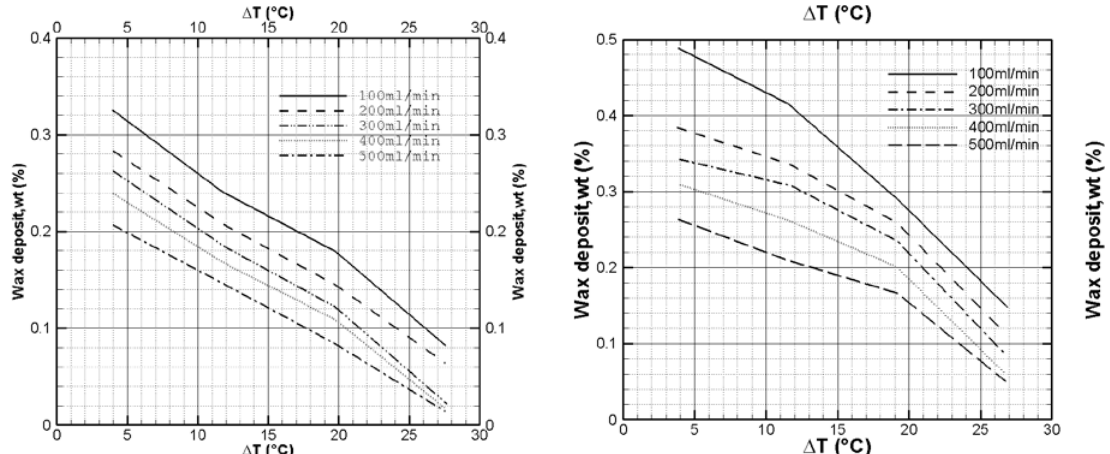
Figure 1 Effect on wax deposit (weight percentage) due to temperature differential at 3 min (kelechukwu et al., 2010)